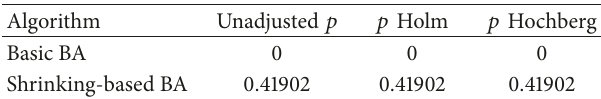
Table 12: Adjusted 𝑝 values associated with BA variants (Friedman) on dynamic benchmark problems 𝐹 1 – 𝐹 6 in terms of the solution quality.